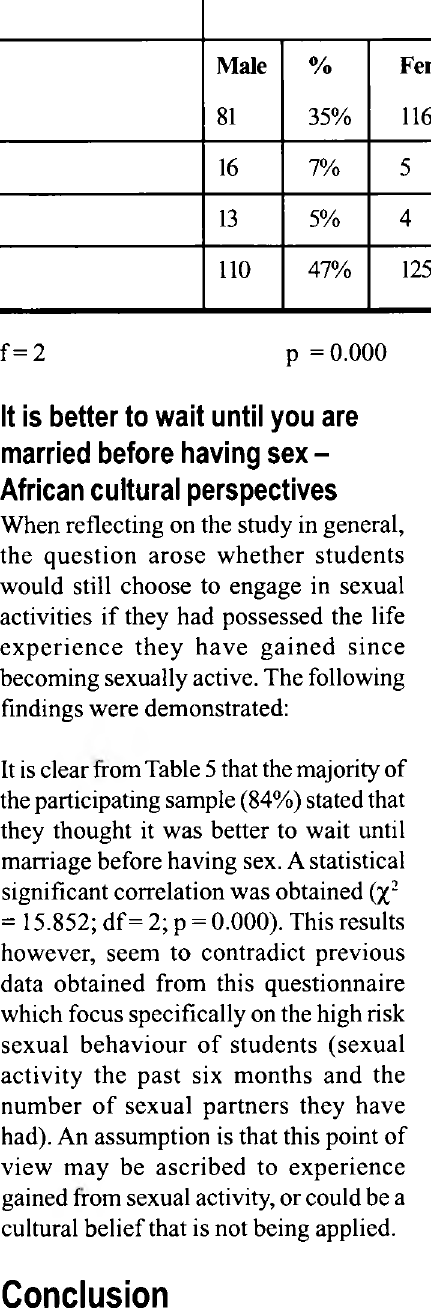
Table 5: Abstinence versus sexual behaviour before marriage - African cultural background “I support the belief that it is better to wait until you are married before having